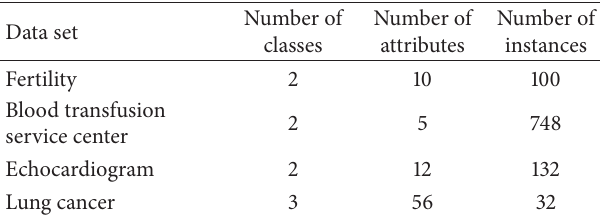
Table 5: Classification results with the fertility data set.